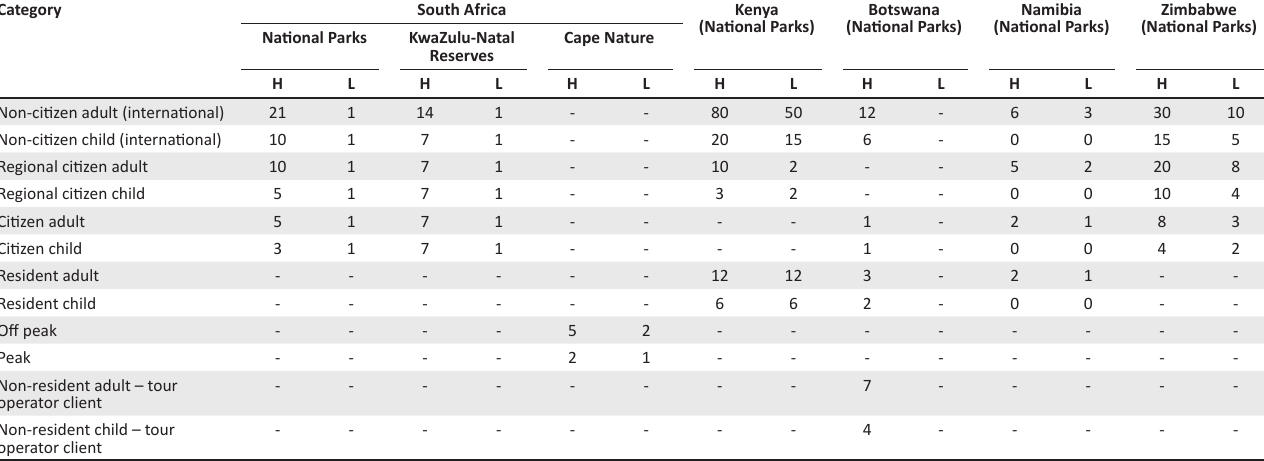
TABLE 2: Entrance fees charged by different protected areas in Africa (USD Equivalent).